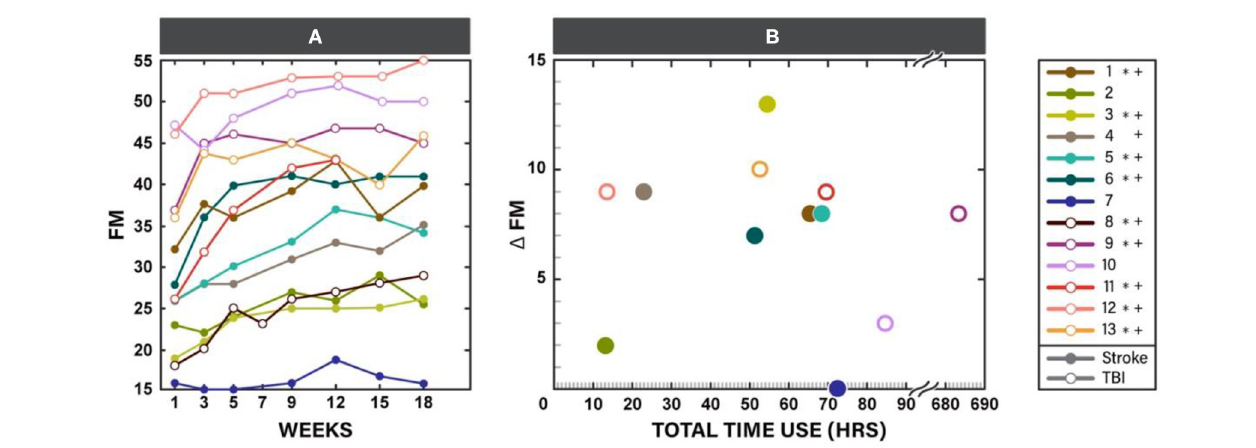
FIGURE 4 | Fugl-Meyer for upper limb (FM) scores for each participant throughout the study participation (A) and scatter plot of change in FM at the end of the study (week 18) vs. total time of Myopro use (B) . * Marks Minimal Clinically Important Difference (MCID) for FM (5.25 points) at the end of the in-clinic phase (week 9); + marks MCID for FM at the end of the home phase (week 18).